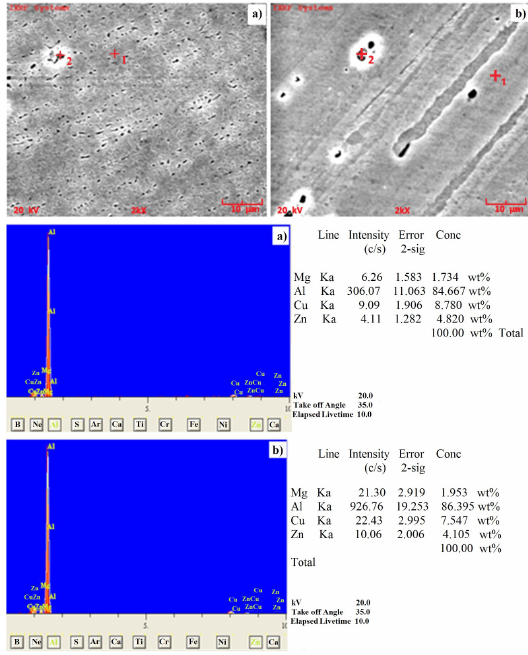
Figure 6. The microstructure of SHTSQ (a) and SHTWQ (b) aged sample at the temperature of 140° C for 10 ve 12 hours ageing time. EDS analysis results a) SHTSQ b)